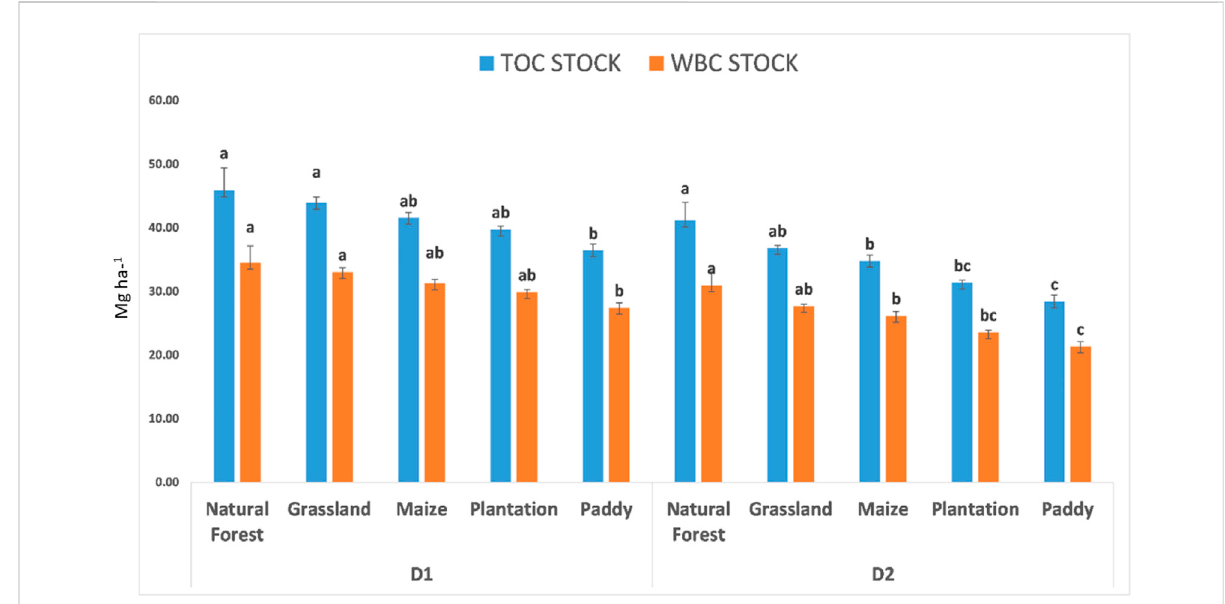
FIGURE 4 EffectoflanduseonTOCandWBCstocks(gkg − 1 )in0 – 20 cmand20 – 40 cmsoildepth.Errorbarsindicatetheleastsigni fi cantdifference(LSD) values at p = 0.05. Mean values with the same letters don ’ t differ signi fi